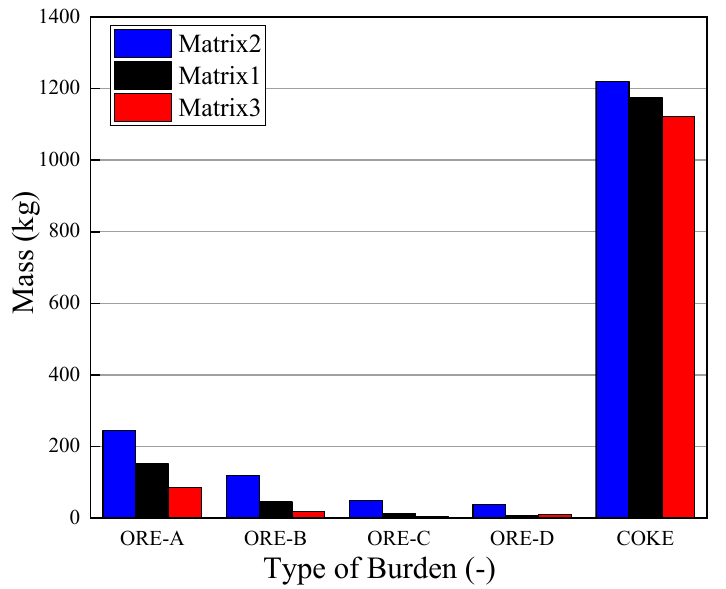
Figure 17. Distribution of charge within the sampling zone in different fabric matrices under the condition that only the angle of the ore in the matrix is changed.